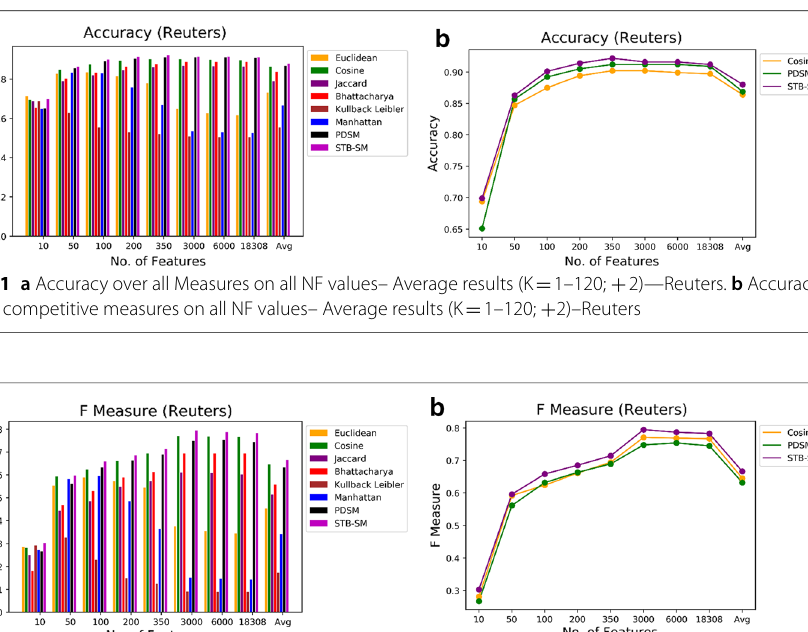
1–120; 2)—Reuters. b = + 1–120; 2)–Reuters = +